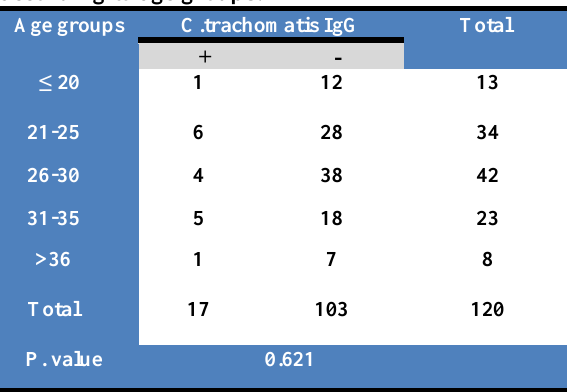
Table, 4: The ratio of Chlamydia trachomatis IgG according to age groups.